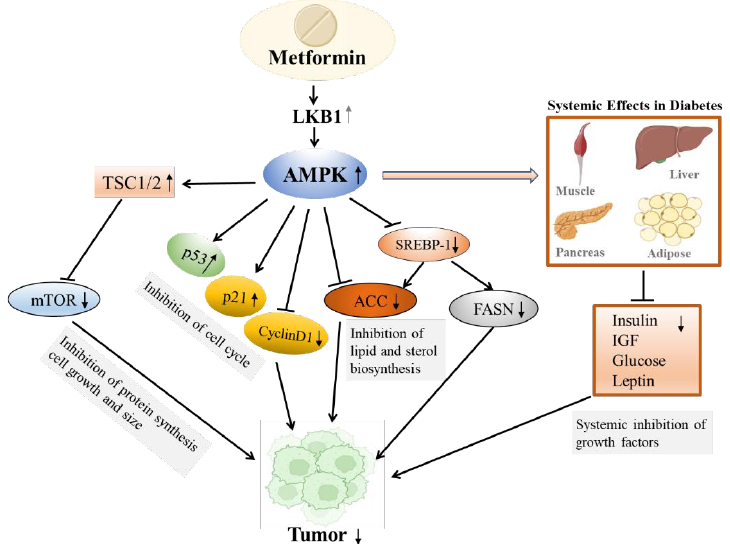
Figure 4. The action of metformin on cancer. Metformin activates adenosine monophosphate activated protein kinase (AMPK), an immediate downstream effector of the tumor suppressor liver kinase B1 (LKB1), resulting in inhibition of tumor growth. The various downstream effects of metformin-mediated AMPK activation in tumor growth inhibition include: (1) activation of the tuberous sclerosis complex (TSC) with inhibition of mammalian target of rapamycin (mTOR) activity, resulting in inhibition of protein synthesis and cell growth; (2) activation of p53 and p21 along with inhibition of cyclins, resulting in cell-cycle arrest; (3) inhibition of lipid and sterol biosynthetic pathways; (4) inhibition of sterol regulatory element-binding protein-1c (SREBP-1) by regulating its expression and phosphorylation, leading to down-regulation of fatty acid synthase (FASN) and acetyl-CoA carboxylase (ACC); (5) direct phosphorylation and inhibition of ACC; and (6) systemic effects on multiple organs such as reducing diabetes-associated cancers by improving glucose balance with reduced levels of growth factors such as insulin, insulin-like growth factor 1 (IGF-1) and leptin which can initiate and promote cancer growth with progression. Metformin had also been shown to reduce cancer events via AMPK-independent mechanisms [113,114] (adapted from reference [115,116]). In experimental studies, metformin induced programmed cell death of cancer cells with inhibition of cell signals, such as vascular endothelial growth factor A (VEGFA), with reduced vascularization of tumor cells [36]. Metformin also modulated the immune response by activating anti-tumor T-cell activity [117]. By reducing oxygen and glucose consumption by tumor cells and increasing the intratumor oxygen levels, metformin sensitized patients’ response s to programmed death-ligand 1 (PD-L1) chemotherapy [118]. By altering the epigenetic signature of tumor cells, metformin also interfered with the signaling pathways that conferred chemoresistance of endometrial cancer cells and improved treatment responses to chemotherapy [119]. A large number of observational studies suggested an association of metformin use with reduced incidence of cancers [120]. In the Taiwan National Health Insurance Data Survey (2000 – 2007) including 12,005 metformin-users and 4597 non-metformin users, metformin use was associated with reduced risk of total, colorectal, liver and pancreatic cancer by up to 88% [121]. In a UK retrospective cohort of 62,809 patients, metformin monotherapy was associated with the lowest cancer risk, compared with insulin or sulfonylureas. Compared with metformin, sulfonylurea monotherapy was associated with a HR of 1.36 (95%CI: 1.19 – 1.54) for solid tumors (breast, colon, pancreas, and prostate cancer). The corresponding HR for combination therapy of metformin and sulfonylurea